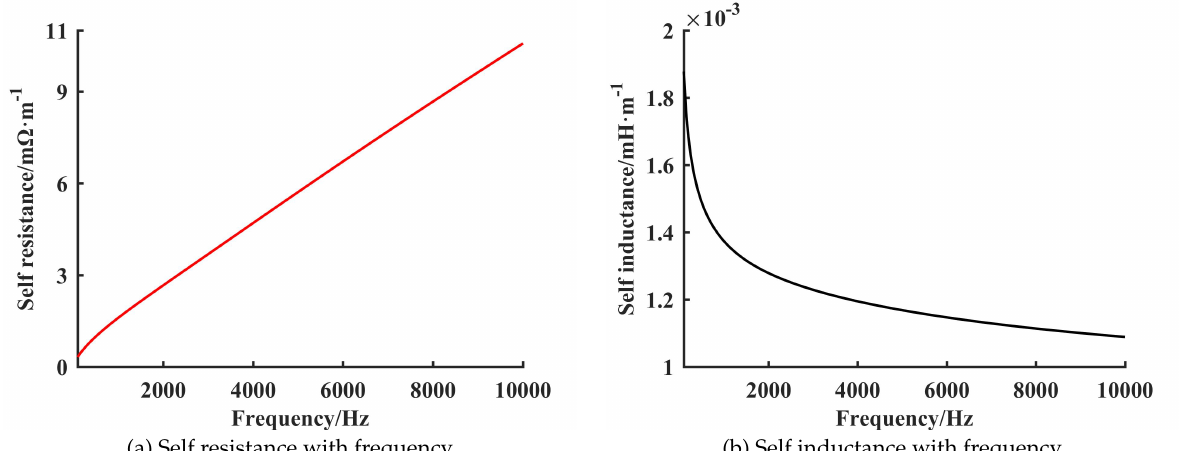
Fig. 10. Variation of rail self-impedance with frequency.